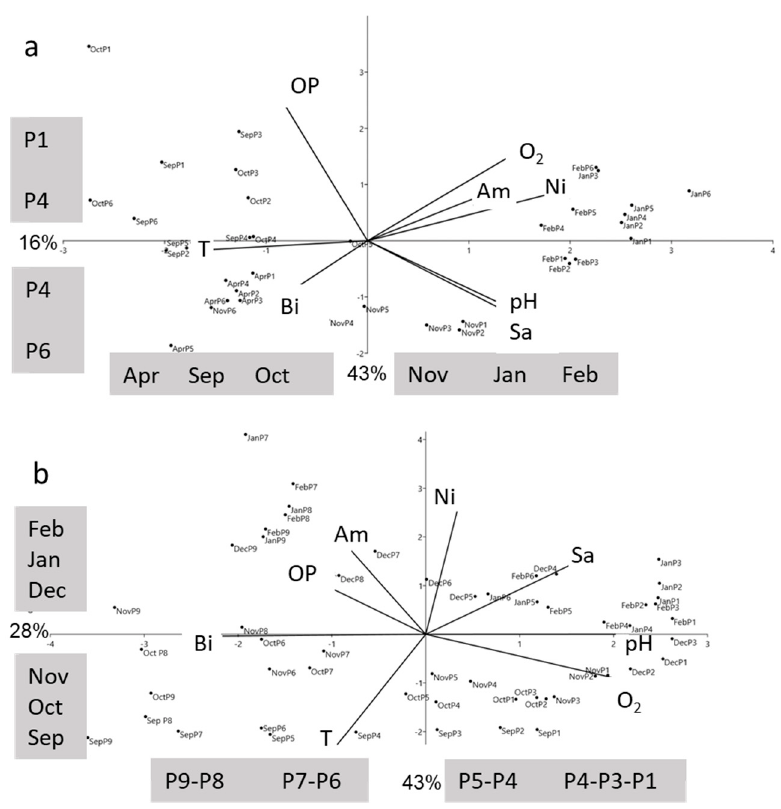
Figure 5. Principal component analysis of samples and limnological variables for ( a ) the Estero del Padre Ramos and ( b ) Estero Salinas Grandes data. Explained variance is shown in each axis. OP: